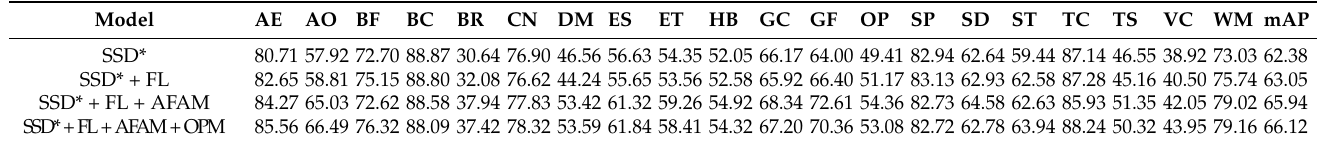
Table 5. Ablation experiments in the DIOR